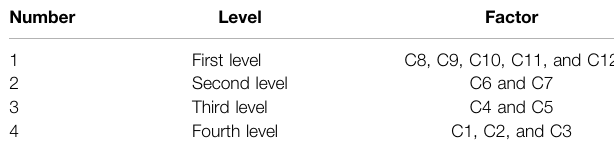
TABLE 3 | Series of restrictive factors for charging piles in the